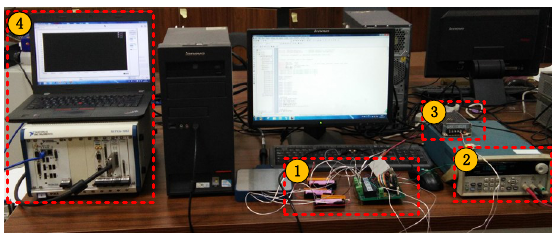
Figure 8. Experiment hardware setup: (1) control board, three batteries and three resistors, (2) CC-CV power source, (3) DC 24 V power source, (4) PXI